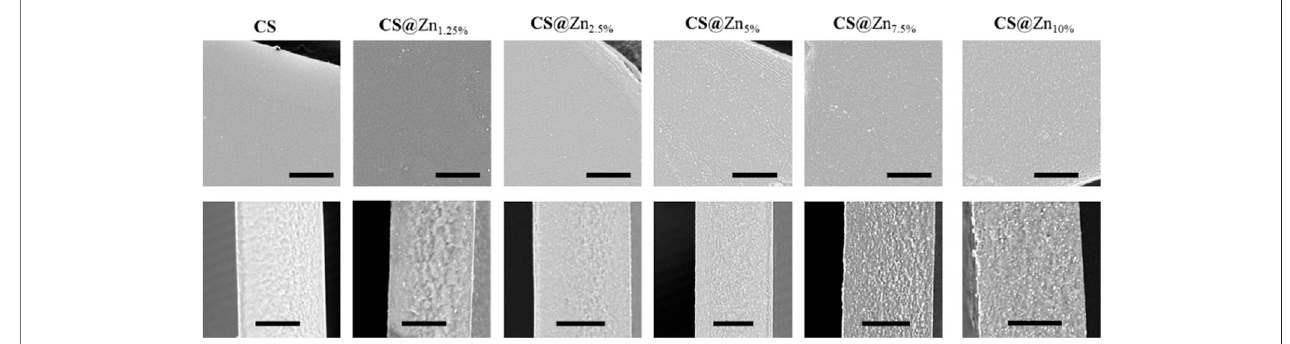
FIGURE 5 | SEM images of the prepared fi lms, up: images of the surface; down: corresponding cross section (scale bars 10 μ m).